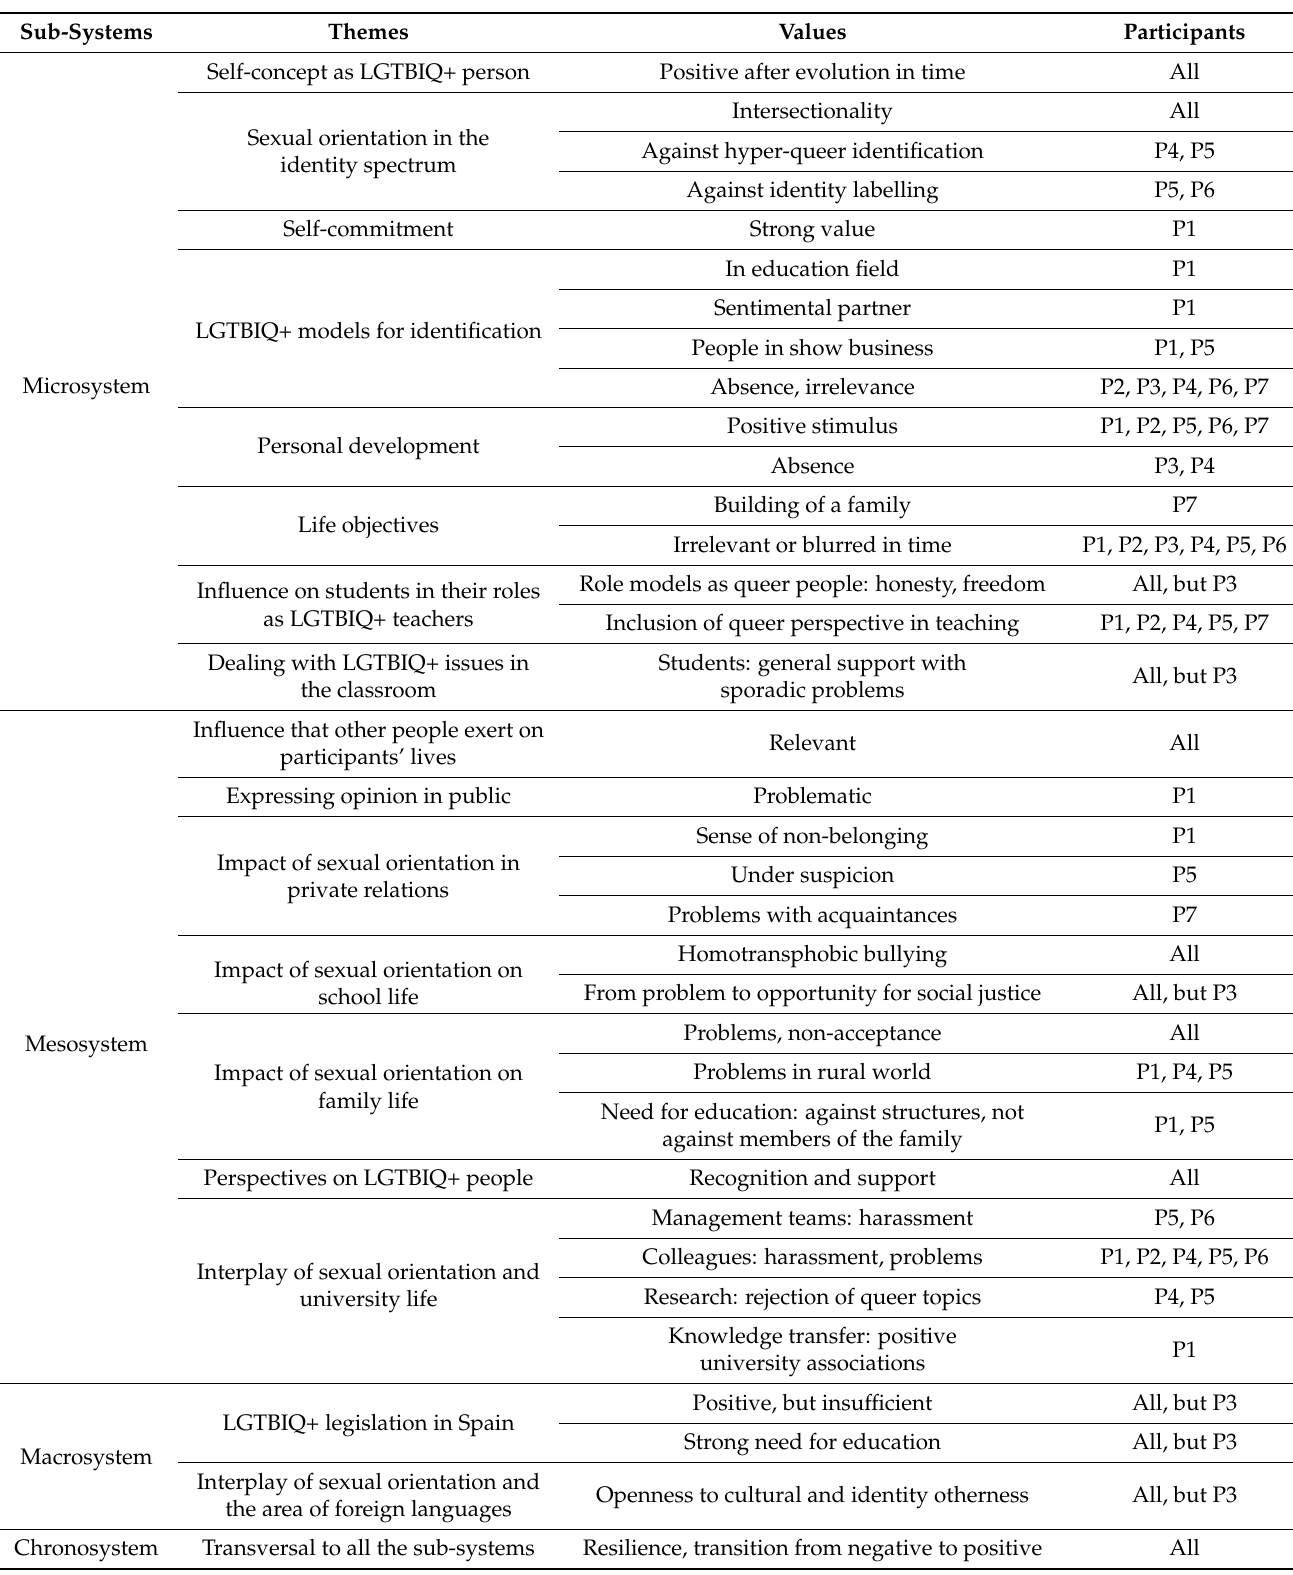
Table 3. Links and interplay of sexual orientation in teacher